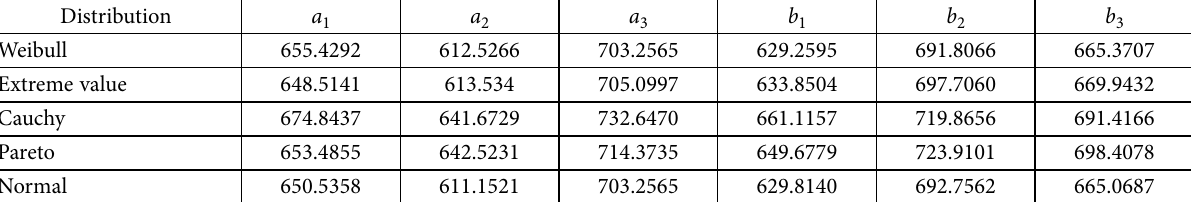
Table 12. BIC of the data set